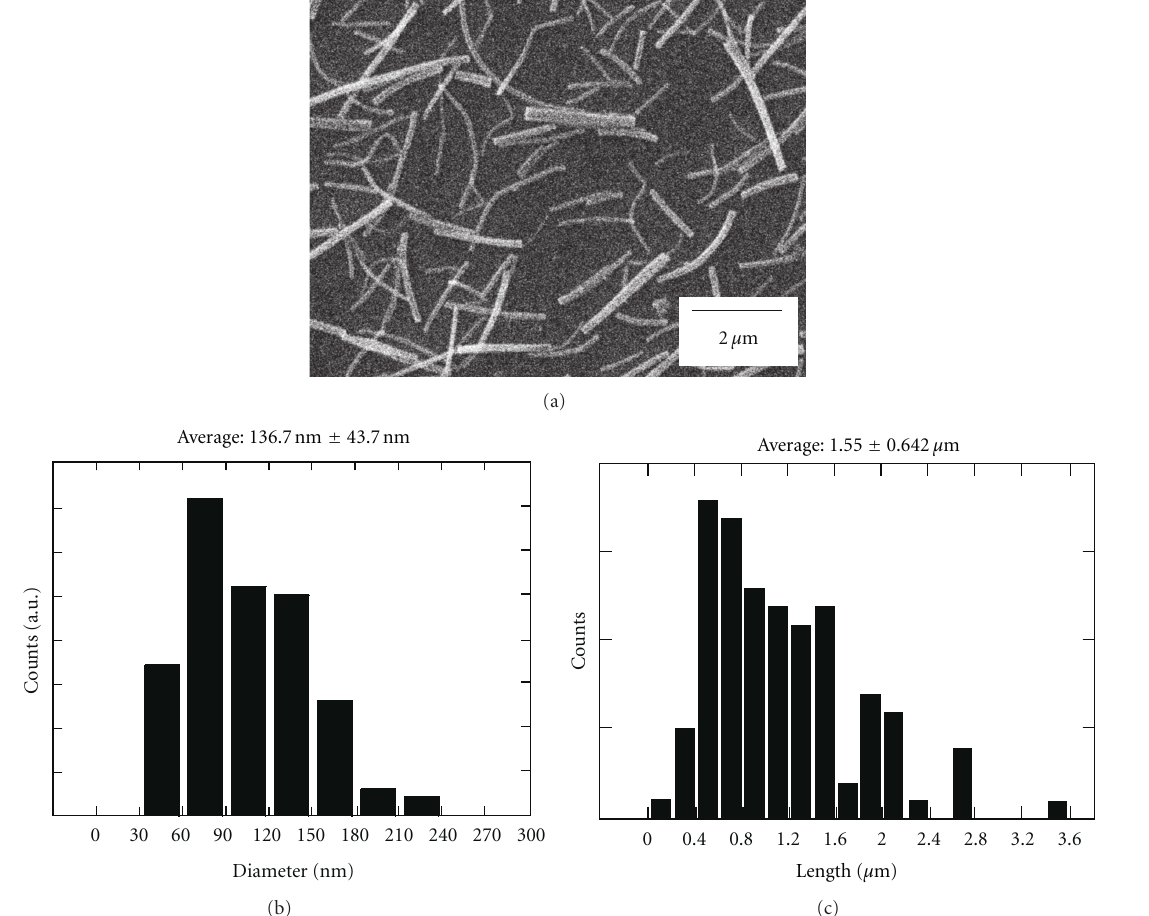
Figure 2: (a) SEM images of the TiO 2 NW coating prepared on a silicon surface, histograms of size distribution for (b) the diameter and (c) the length of the NWs.